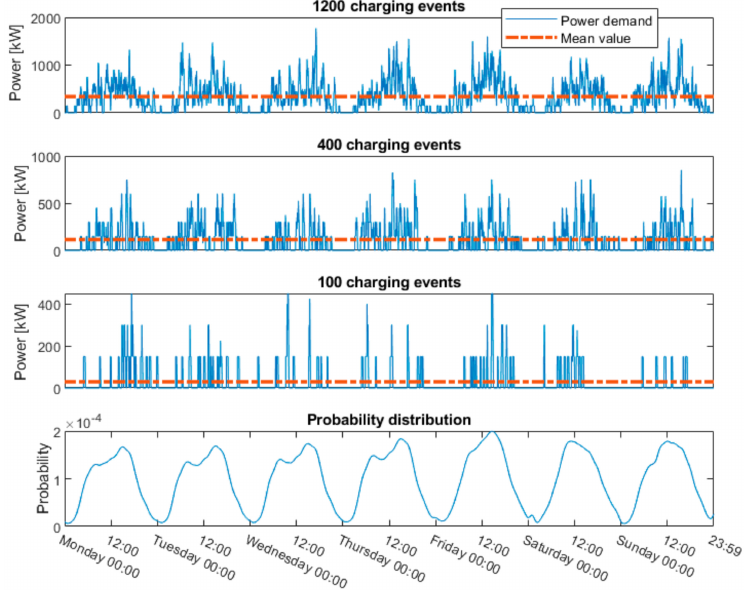
Figure 1. Stochastic distribution of charging events and average power.